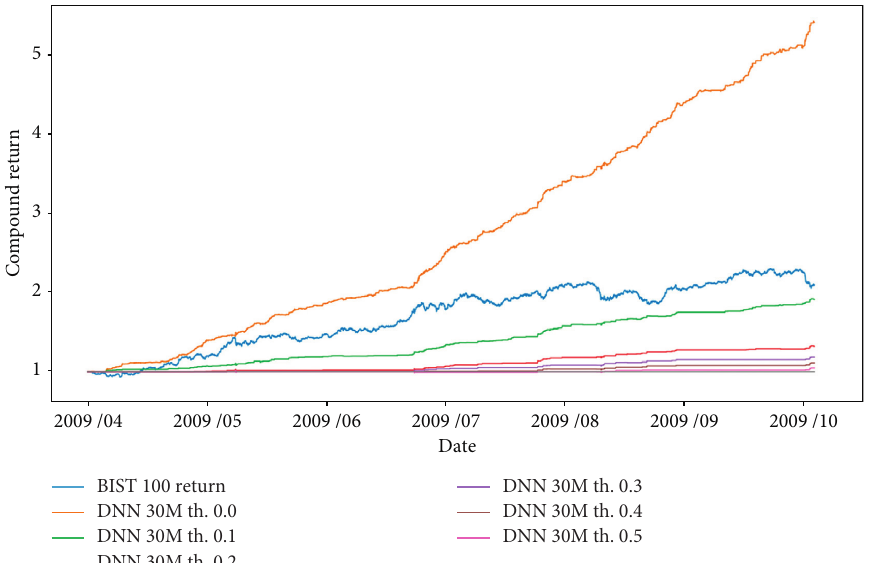
Figure 5: Comparison of one of the most profitable periods of BIST 100 index with the return of 30min DNN.